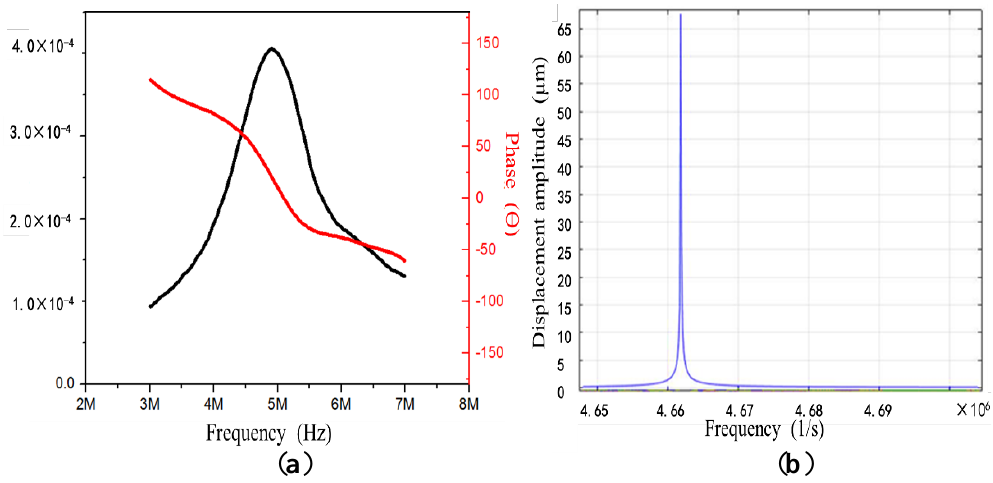
Figure 8. ( a ) Frequency response curve of the ultrasonic transducer array (laser Doppler vibrometer); ( b ) vibration modes and frequency response of the ultrasonic transducer array (finite element simulation).